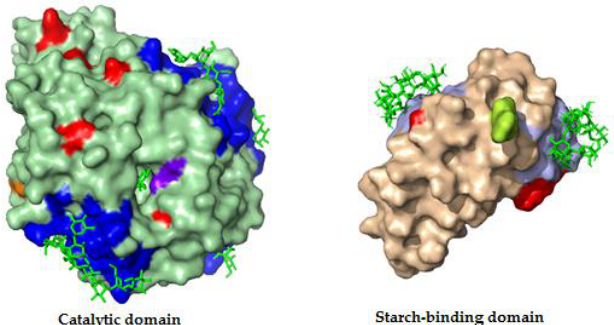
Figure 1. Three-dimensional structures of A. niger amyloglucosidase, showing the catalytic domain on the left and the starch-binding domain on the right (3eqa and 1ac0 PDB structures [4,5], respectively). Color patterns: red (lysine residues), purple (active site), orange (N-terminal residue), lemon (C-terminal residue), blue and light blue (glycosylated regions in the catalytic and starch binding domains, respectively). The figures were generated using PyMol (The PyMol Molecular Graphics System; Version 2.1.0; Schrödinger, LLC).